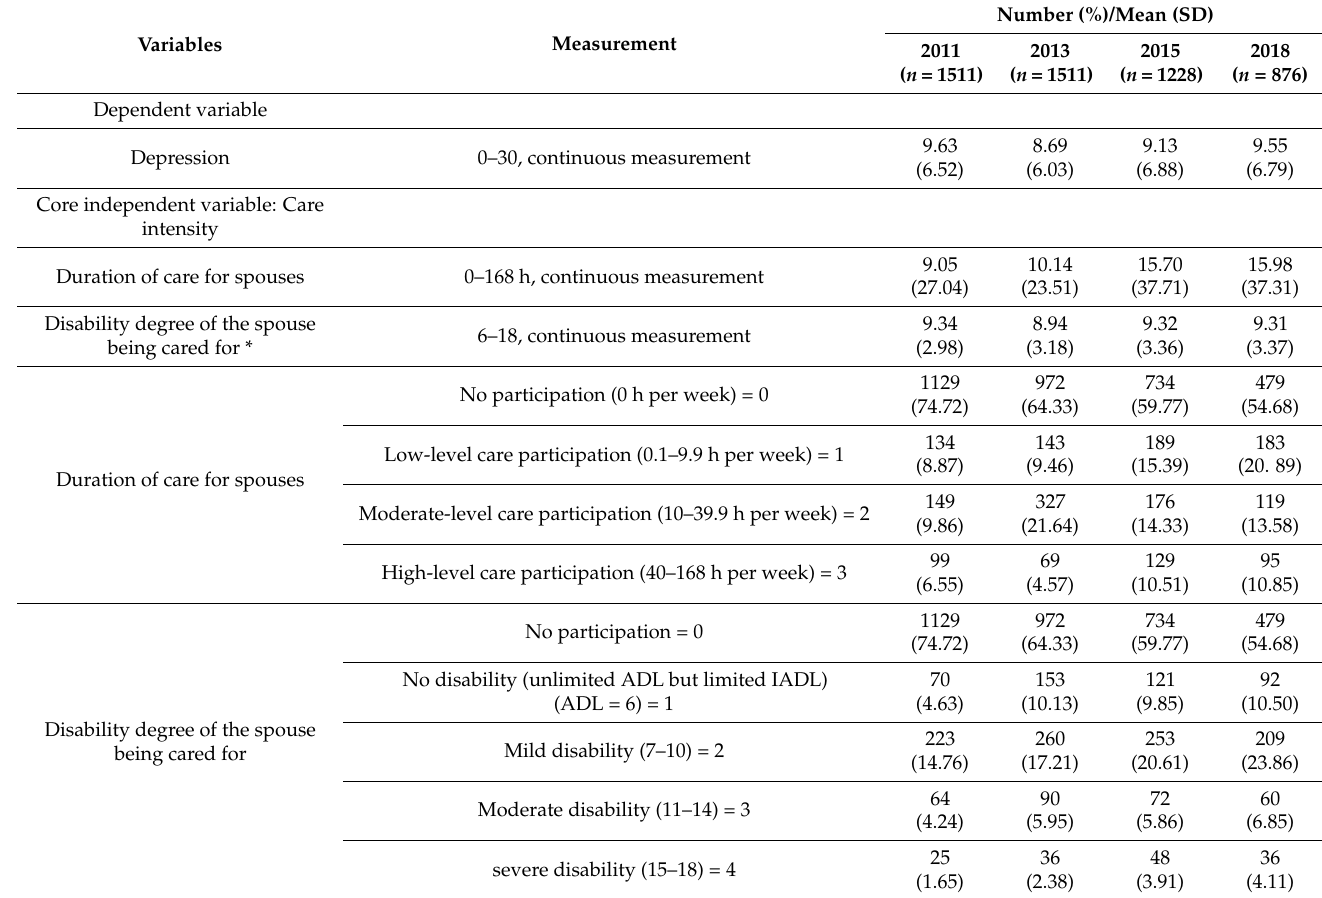
Table 1. Descriptive statistics of the sample